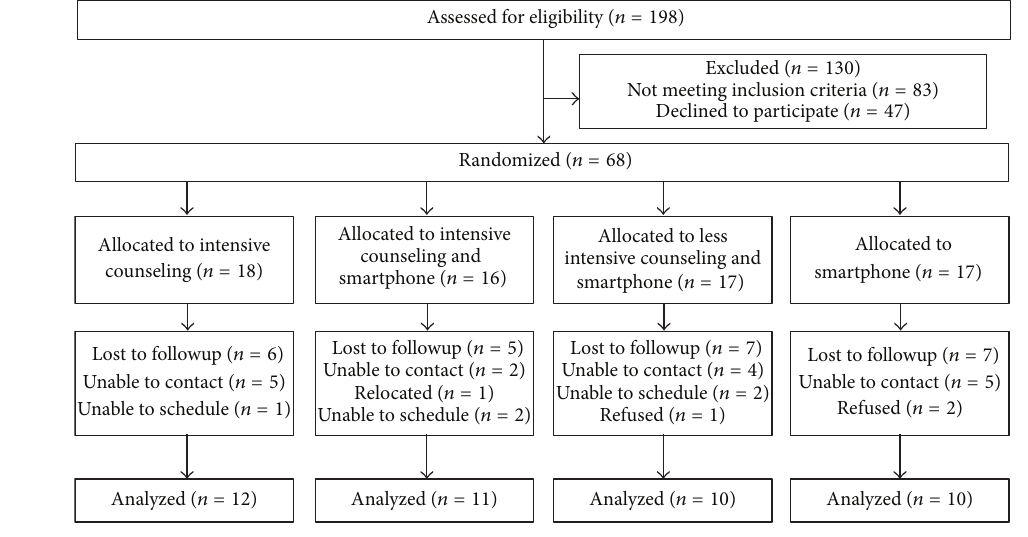
Figure 1: Study flow diagram. Table 2: Utilization of